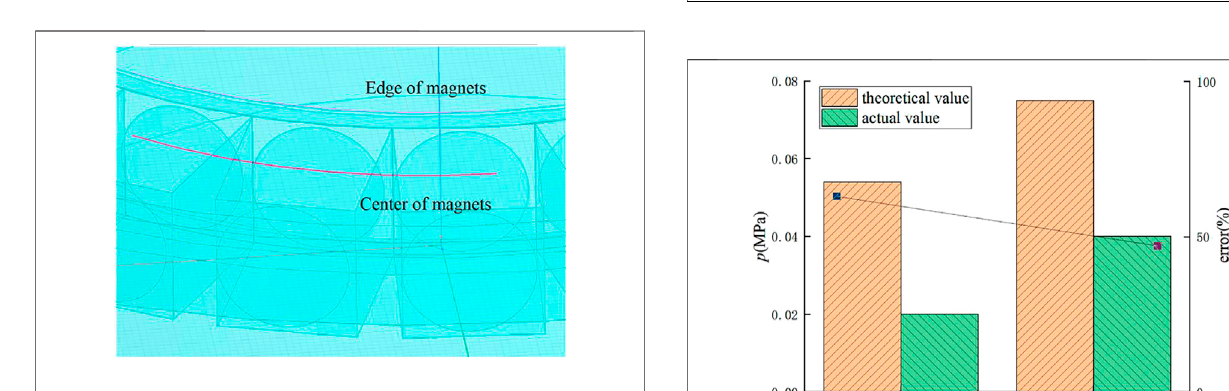
FIGURE 10 | Arcs in the seal gap.